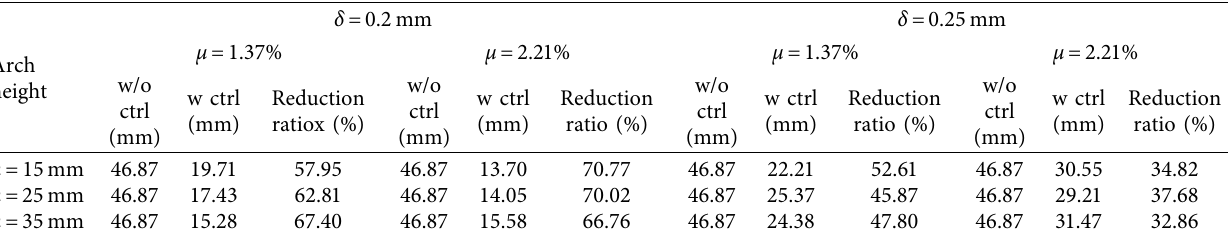
Figure 8: Time-history response of frame structure under diferent parameters: (a) δ � 0.2 mm, μ � 1.37%, (b) δ � 0.2 mm, μ � 2.21%, (c) δ � 0.25 mm, μ � 1.37%, and (d) δ � 0.25 mm, μ � Table 5: Reduction of the peak displacement.